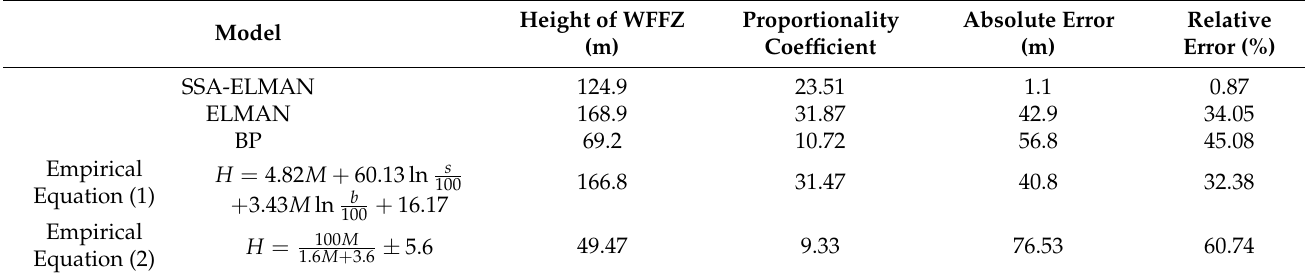
Table 3. Comparison of the prediction results of the different